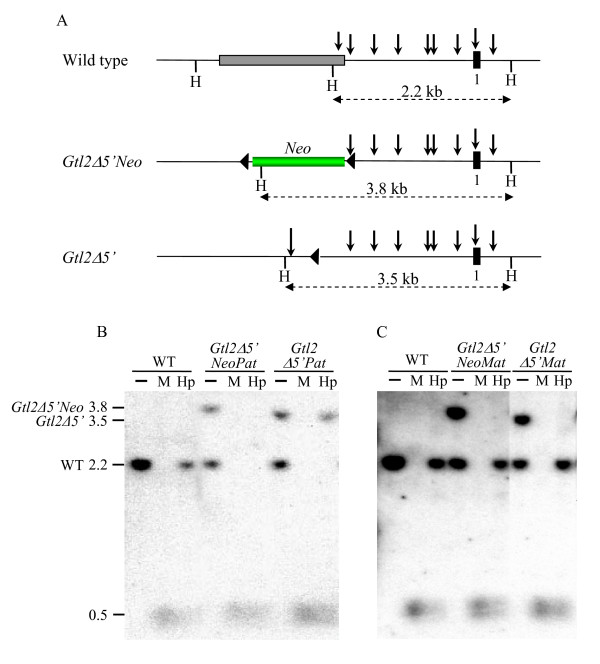
Methylation analysis of the Gtl2 DMR in Gtl2Δ5'NeoPat and Gtl2Δ5'Pat embryos. A) Schematic of the Gtl2 DMR region in wild type, Gtl2Δ5'Neo and Gtl2Δ5' alleles. The grey box represents the Gtl2Δ5' deletion region, the green box represents the Neo gene and the black box represents Gtl2 exon 1. The vertical arrows represent recognition sites for the MspI/HpaII restriction enzymes, and the loxP sites are indicated by black triangles. The methylation assay detects a 2.2-kb endogenous HincII fragment that spans the Gtl2 DMR. Modifications in the Gtl2Δ5'Neo and Gtl2Δ5' alleles generate 3.8-kb and 3.5-kb fragments, respectively. B) Methylation assay for the Gtl2 DMR in Gtl2Δ5'NeoPat129 and Gtl2Δ5'Pat129 embryos. C) Methylation assay for the Gtl2 DMR in Gtl2Δ5'NeoMat129 and Gtl2Δ5'Mat129 embryos. Restriction sites are, H, HincII, Hp, HpaII and M, MspI.